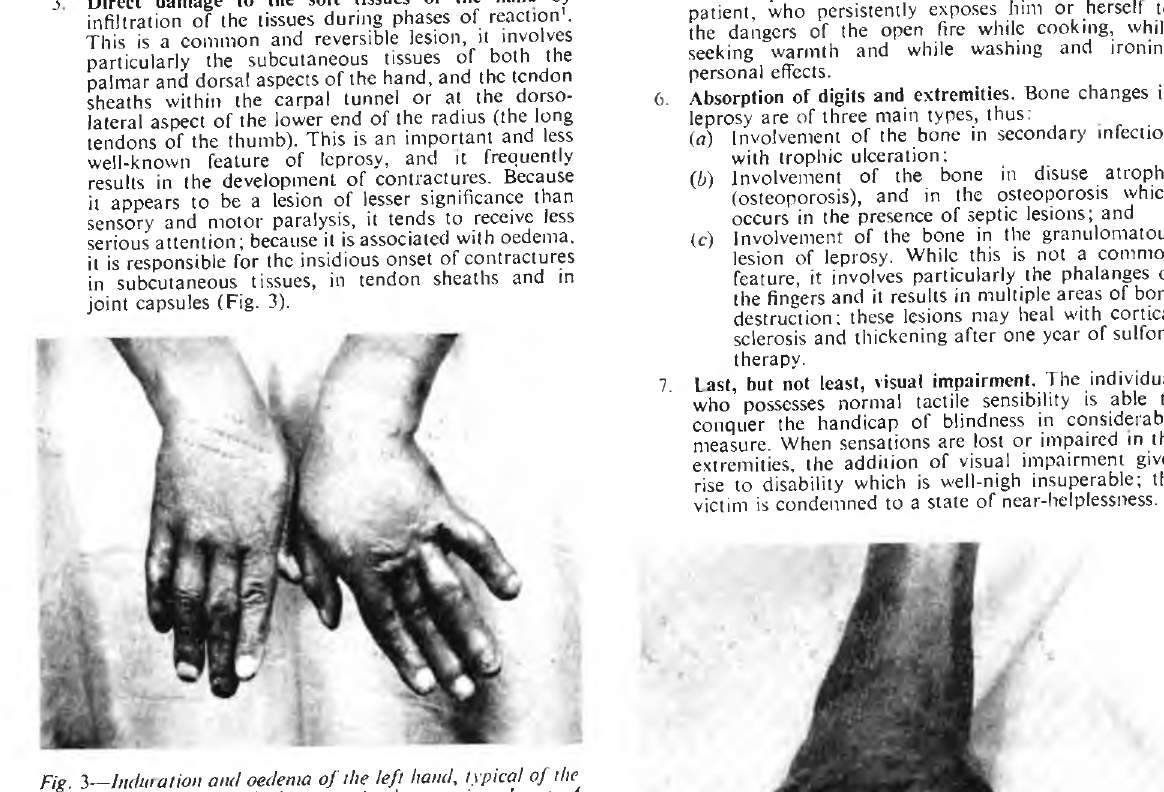
fig . 3 — Inclin ation and oedema o f the left hand, typical o f the soft tissue infiltration which occurs in the reactive phases oj leprosy. This is a reversible lesion.